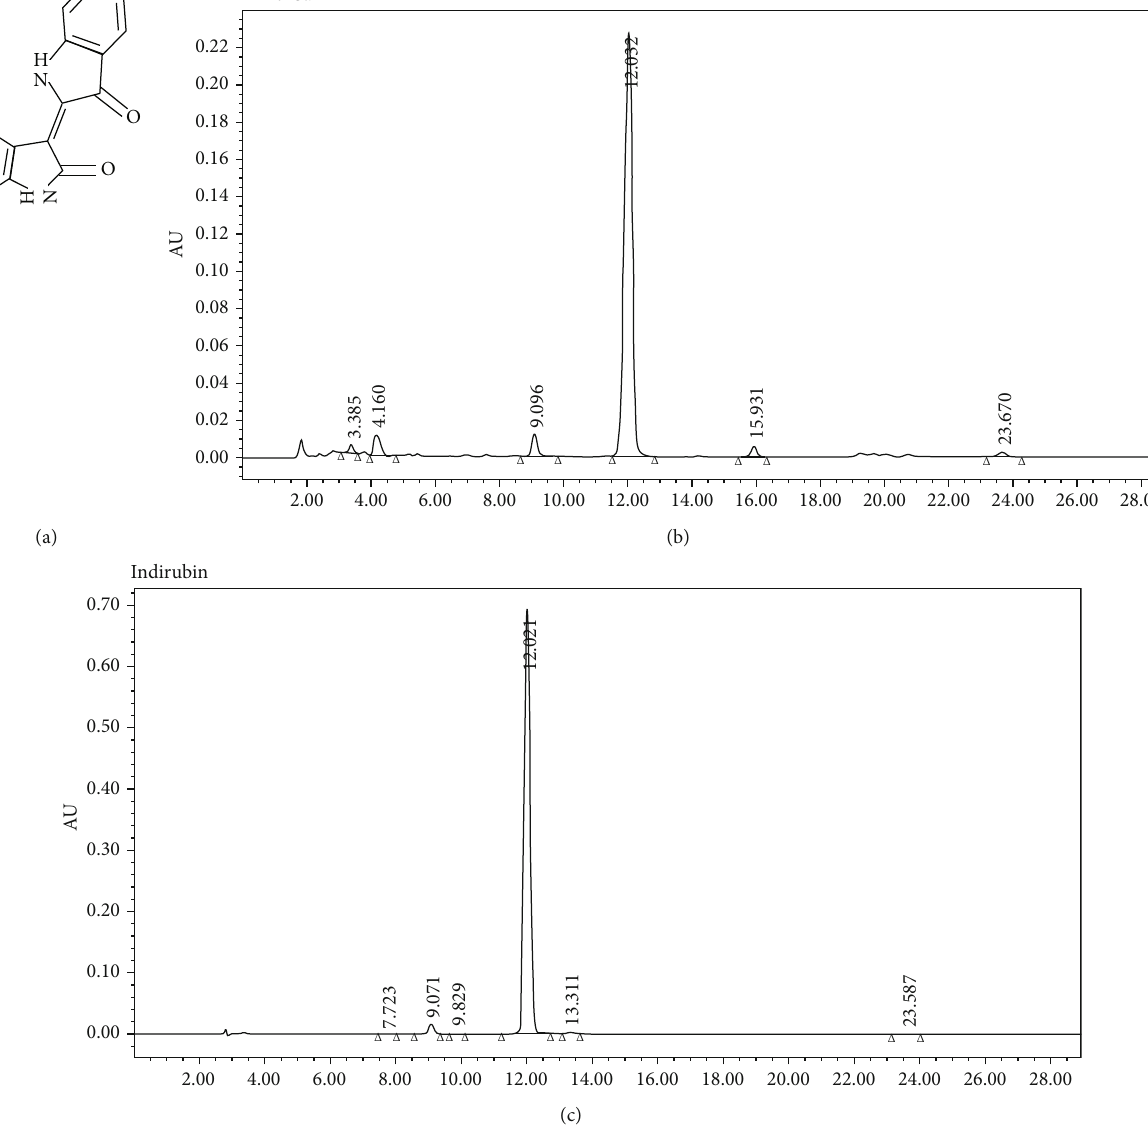
Figure 1: Xi Lei San and indirubin were identi fi ed by HPLC. (a) The molecular structure of indirubin. The chromatograms of (b) Xi Lei San and (c) indirubin as obtained by